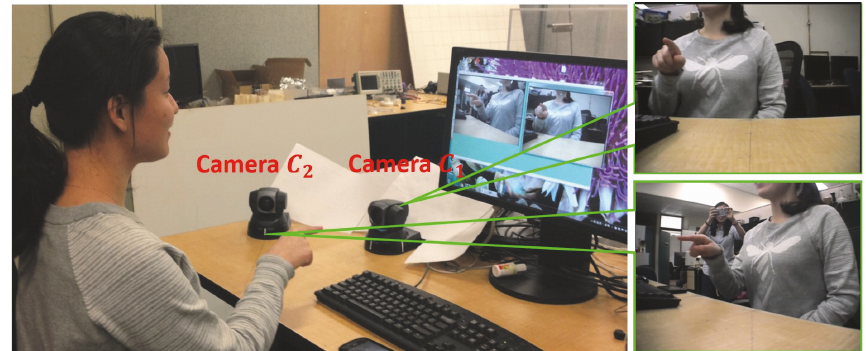
Figure 8: The system setup of two cameras. The example frames taken by camera 𝐶 1 and 𝐶 2 are listed on the left of this image.